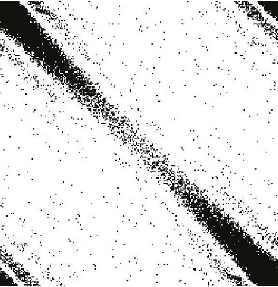
Figure 8: White coloured desensitised